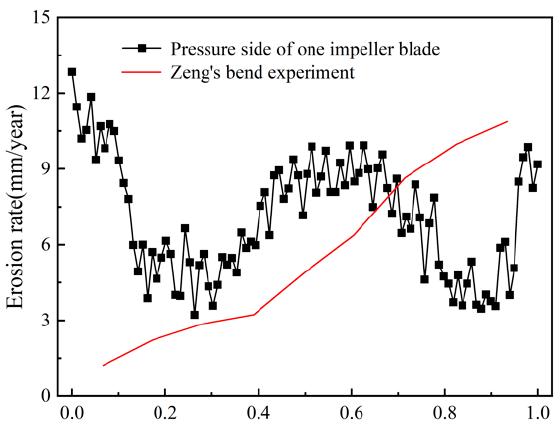
Figure 8. Comparison of the predicted erosion rate on the pressure side of the blade and along the extrados of the bend measured in Zeng’s experiment.